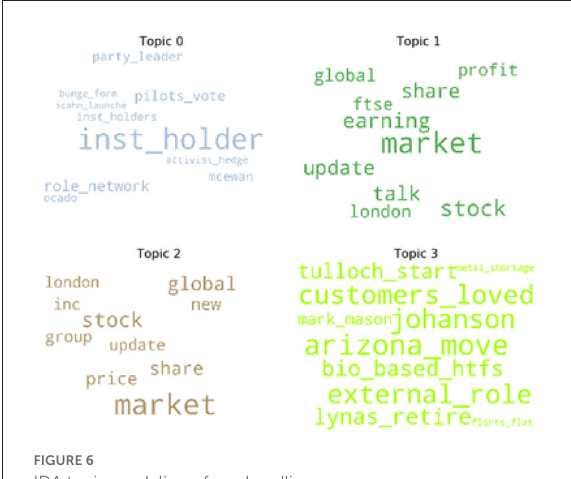
FIGURE6 IDA topic modeling of our headlines corpus.